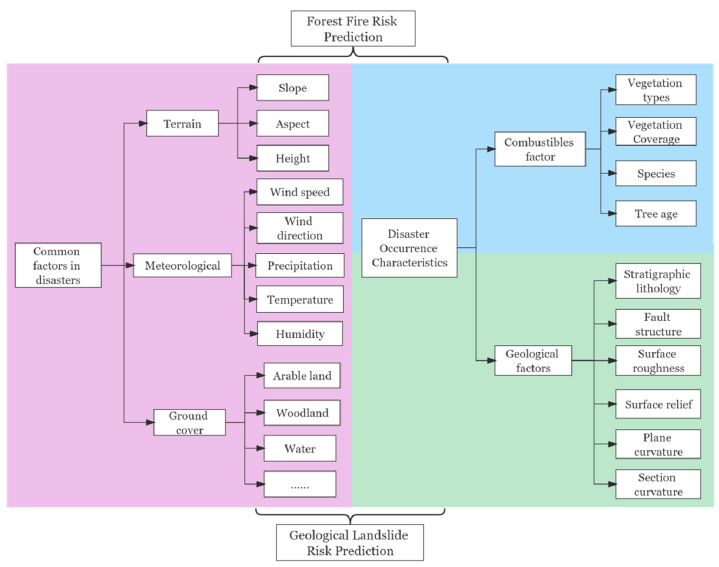
Figure 1. A hierarchical semantic model for disaster prediction scenarios regarding forest fires and geological landslides.